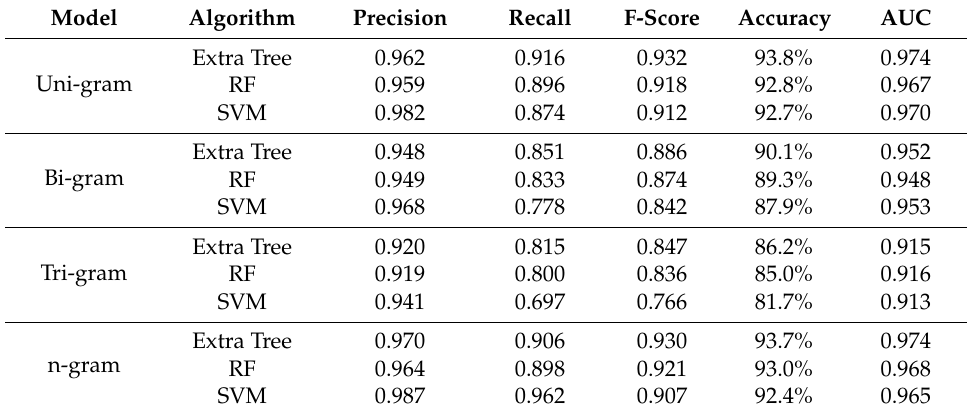
Table 7. Summary for classification algorithms with n-gram model on test dataset.